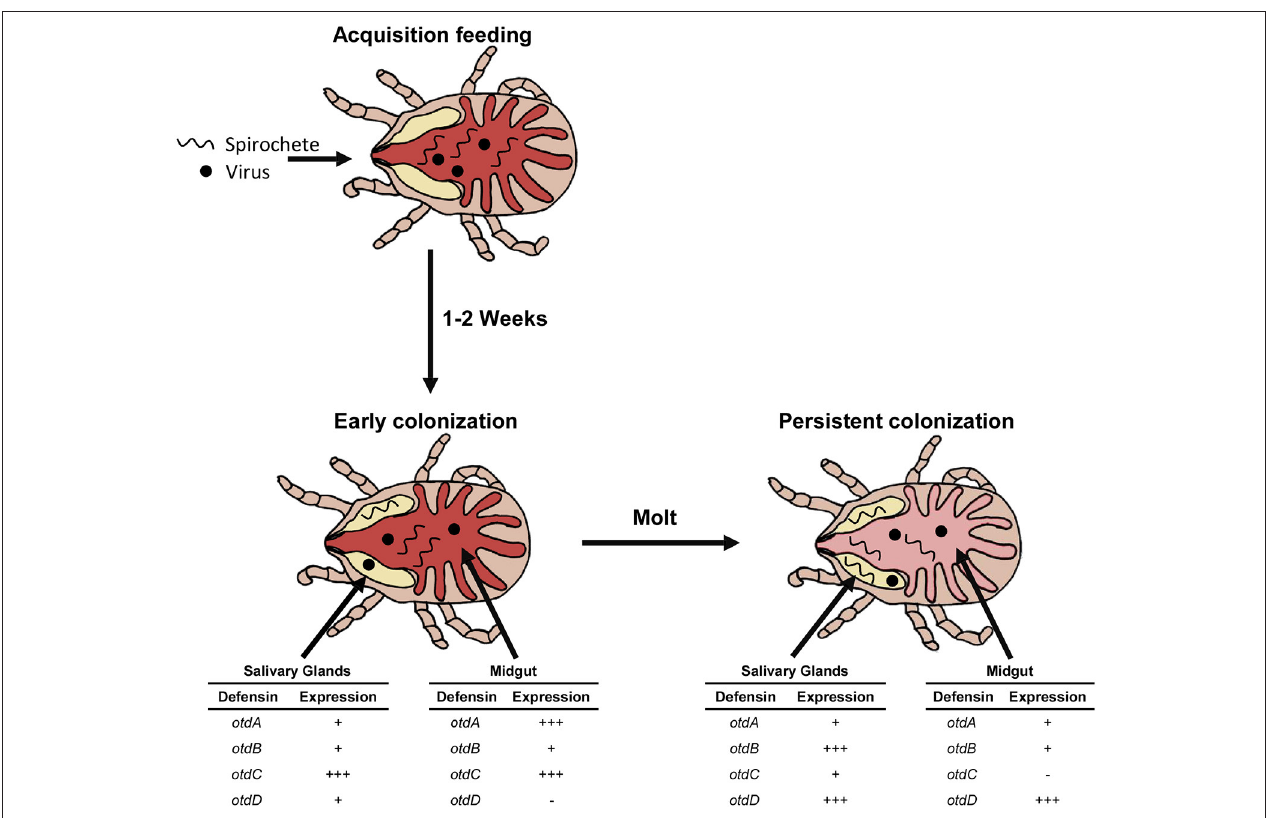
FIGURE 5 | Model of pathogen colonization and defensin expression. Spirochetes and viruses are imbibed during the acquisition blood feeding and enter the midgut (red). Over the next 1–2 weeks a subset of the population migrates out of the midgut to colonize the salivary glands (yellow). At this time there is an upregulation ( + + + ) of otdA and otdC in the midgut and otdC in the salivary glands. otdB is expressed ( + ) in the midgut. otdD is not expressed in the midgut (-) but transcript detected in the salivary glands with otdA and otdB . This characterizes early pathogen colonization of the tick. Persistent colonization occurs after the tick has molted and the pathogen remain in both the midgut (light red) and salivary glands. In the midgut otdA and otdB are expressed ( + ), otdC is not expressed (-), and otdD is upregulated ( + + + ). In the salivary glands otdA and otdC are expressed ( + ), while otdB and otdD are upregulated ( + + +